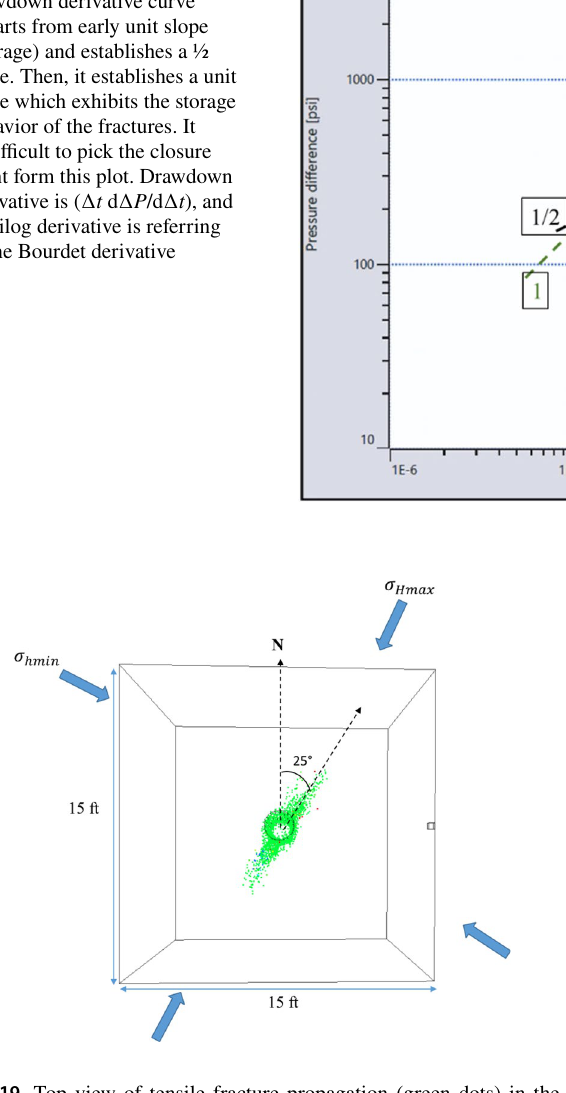
Fig. 18 Log–log diagnostic plot for the DFIT test simulation with a single fracture with dip direction of 60°. The semilog drawdown derivative curve departs from early unit slope (storage) and establishes a ½ slope. Then, it establishes a unit slope which exhibits the storage behavior of the fractures. It is difficult to pick the closure point form this plot. Drawdown derivative is (∆ t d∆ P /d∆ t ), and